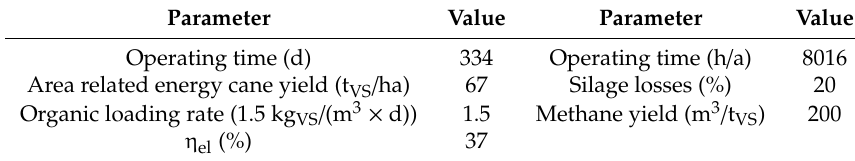
Table 6. Parameters of a 500 kW el biogas plant fed with energy cane based on the results of this